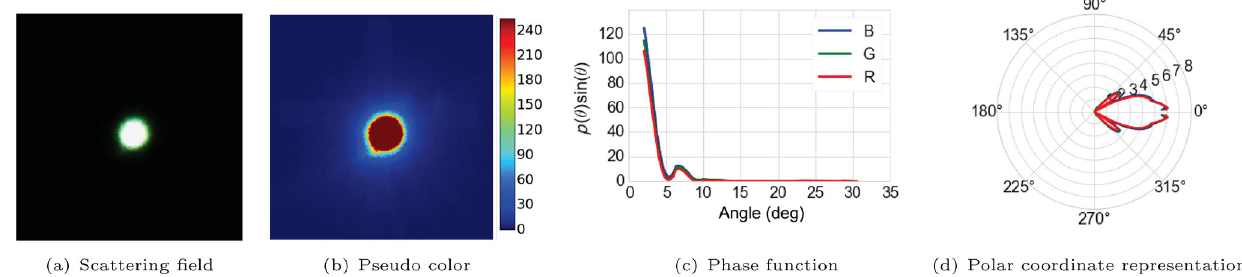
Fig. 6 Experimental result for apple juice. (a) Scattering field captured through screen at bottom. (b) Pseudo-color of captured scattering field. (c) Measured phase function versus scattering angle. (d) Polar plot of phase function. The incident direction is from left to right and intensity is given on a log